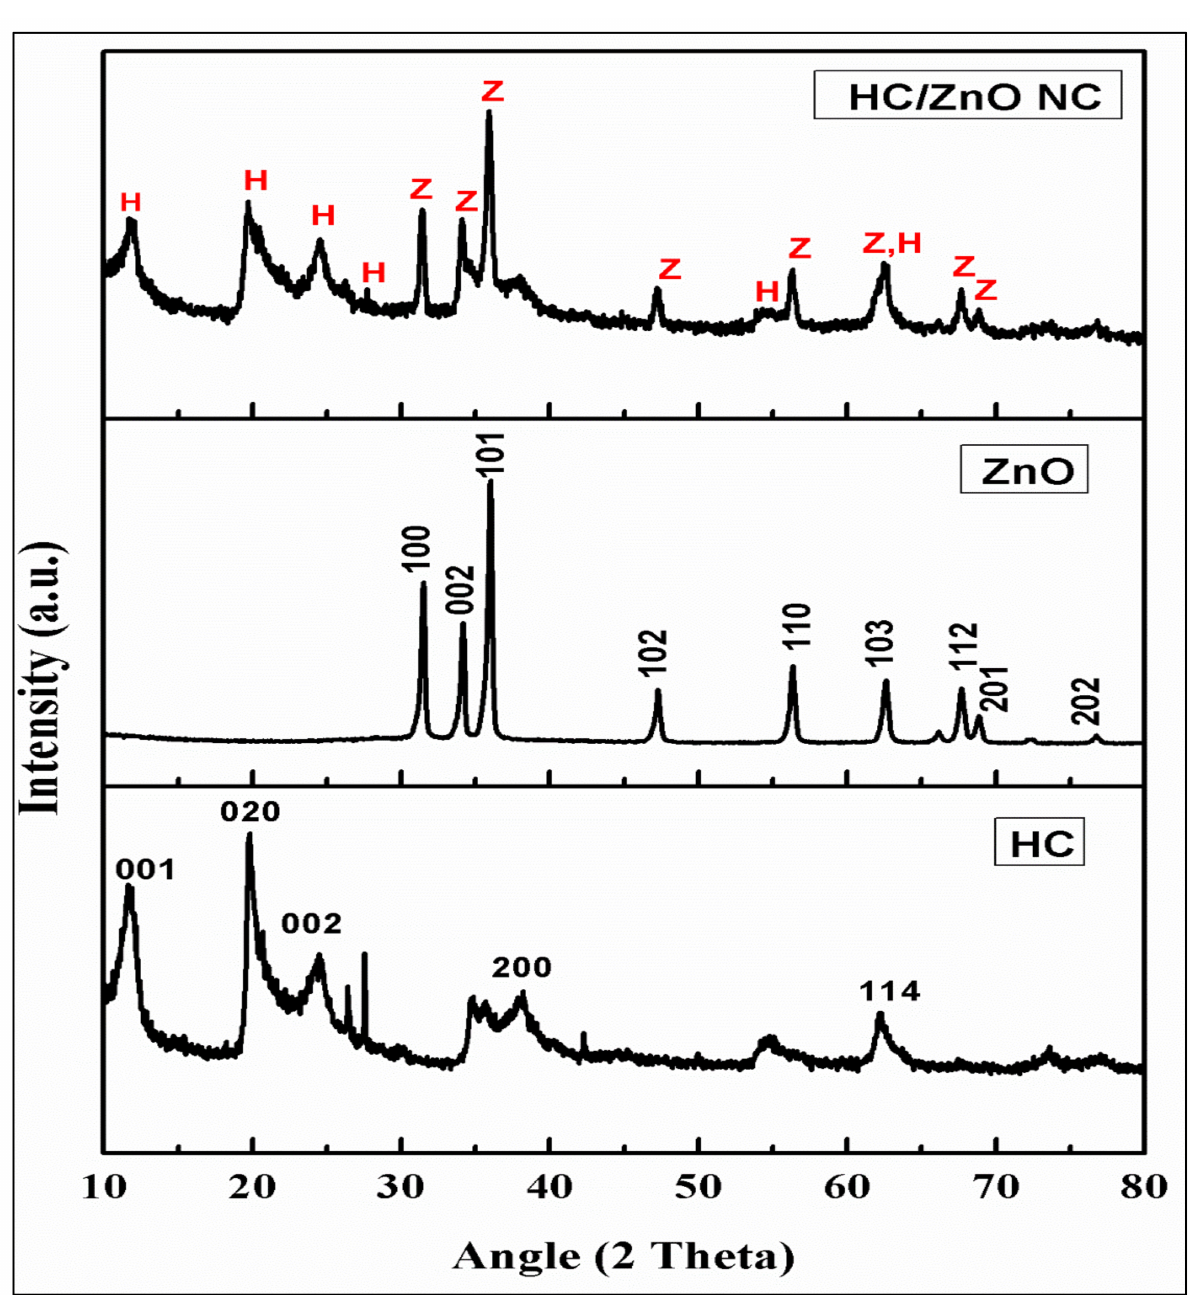
Figure 7. XRD patterns for HC, ZnONPs and HC/ZnONC. The XRD patterns of HC show peaks at 11.7 ◦ (d = 7.5 Å), 19.8 ◦ (d = 4.4 Å), and 24.53 ◦ (d = 3.6 Å), 38.25 ◦ (d = 2.3 Å), 62.36 ◦ (d = 1.4 Å), which match up with the crystallographic orientations of (001), (020), (002), (200) and (114), respectively. The obtained peaks were matched with the JCPDS (card no. 09-0451) of HC, which confirmed the particle. The peak at 11.95 ◦ is due to the partially dehydrated HC, and the position of reflection is 001. The peak near 26.5 ◦ is due to the quartz and mullite presence in the clay samples due to alumino-silicates mineral. A similar quartz peak was also obtained by Zsirka et al. [56], whose peak was at 26.6 8 . It shows a sharp peak, as clay has hydrates of Si and Al. Similar results were also revealed by various investigators such as Gaaz et al. [68] and Shu et al. [51]. The XRD pattern of HC/ZnONC shows all the peaks of both the original particles, which suggests the successful crystallization of the ZnONPs on the HC surface.